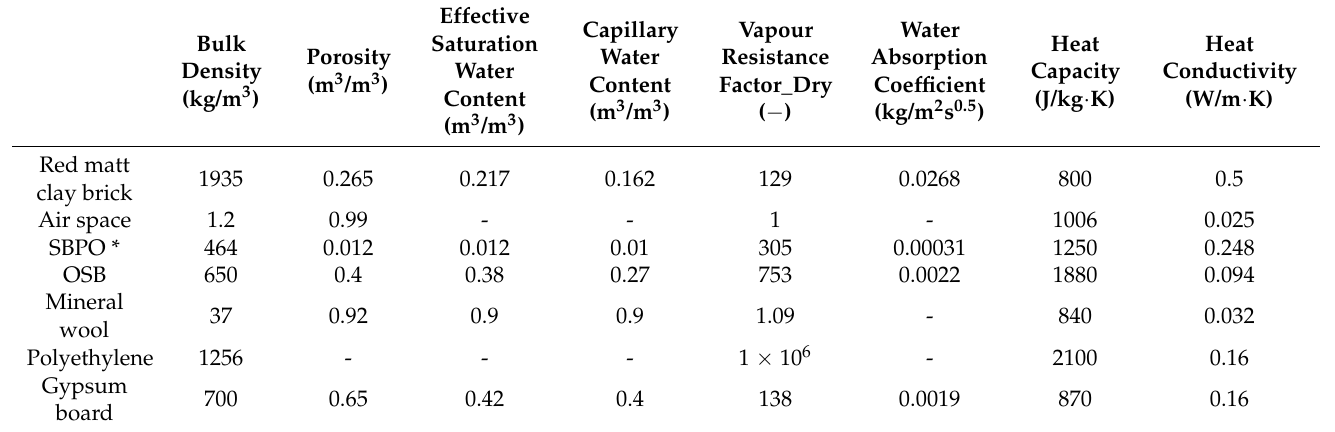
Table 1. Basic material properties of the wall components.